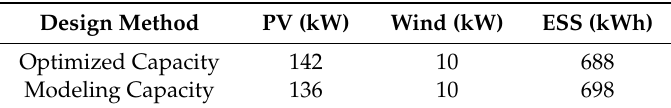
Table 12. Comparison of optimized capacity by real load pattern with modeling one using estimated load pattern for Island 7.